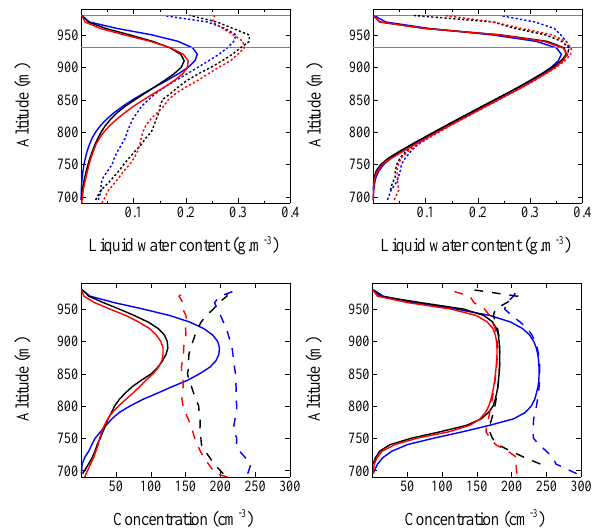
Fig. 2. Vertical profiles of LWC (top) and cloud droplet number concentration (bottom) averaged over N max (Solid line) and over N(k) (dashed line) for the DRY (left) and WET (right) case. Blue, black and red correspond to the “adjustment” or A, “diagnostic” or B, and “pseudo-prognostic” or C schemes, respectively. The upper 100m of the cloud layer is represented by the two green